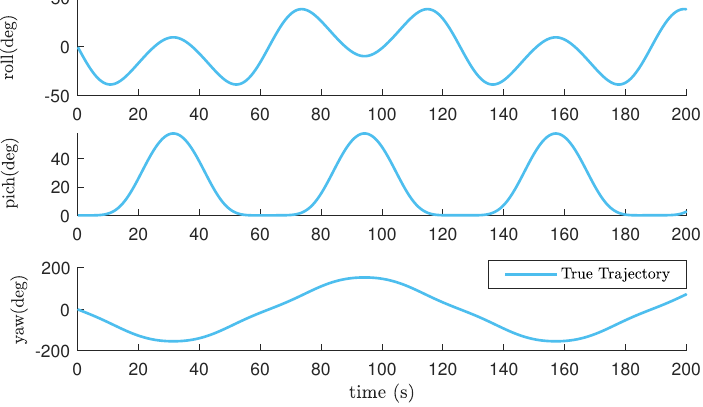
Figure 2. True trajectory of Euler angles in Cases 1 and 2.